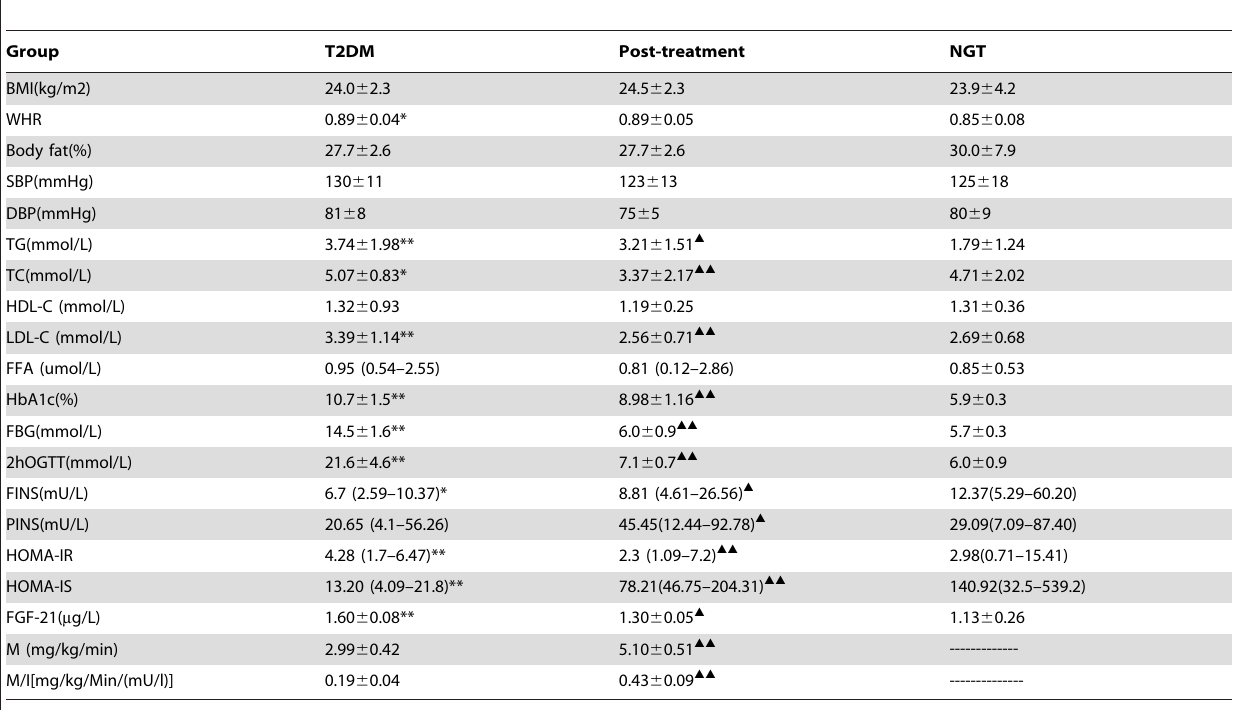
Table 1. Clinical characteristics and FGF-21 levels of study